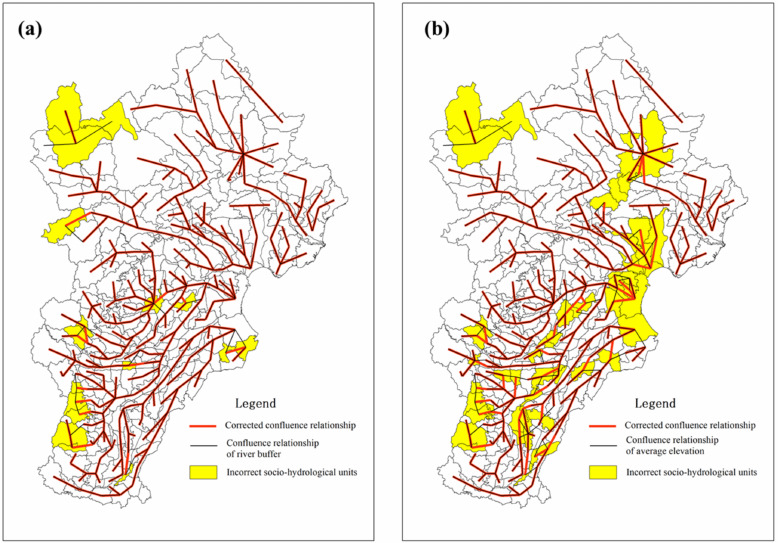
Figure 13. The difference between corrected confluence relationship and ( a ) confluence relationship of river buffer, and ( b ) confluence relationship of average